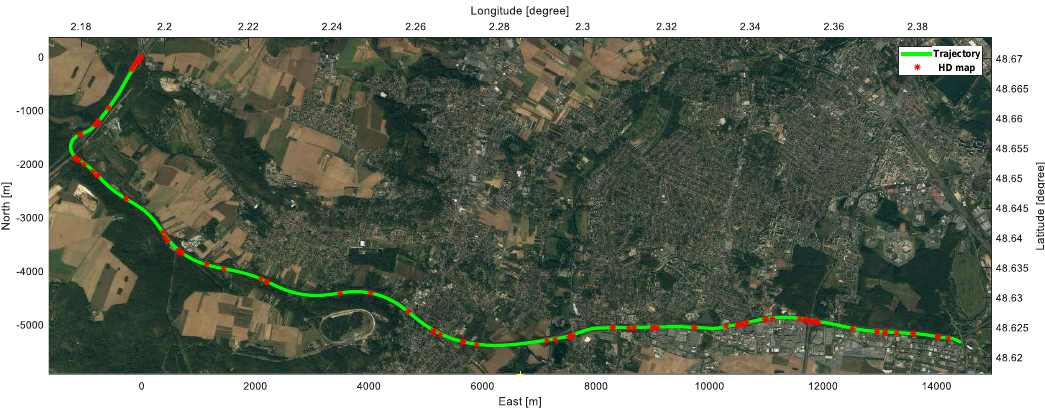
Figure 7. Test sites for the evaluation of the SLAMCU. The green line represents the 20 km-long highway trajectory, the red points shows the position of traffic signs on the HD